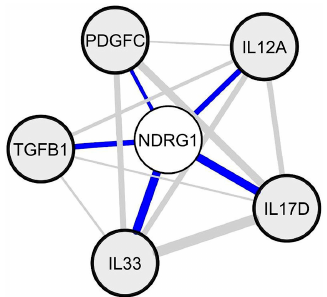
Figure 7. Identification of candidate soluble factors that putatively repress NDRG1 expression. Starting from a list of 193 candidate genes coding for cytokines, chemokines or growth factors, we used the GeneMANIA software to identify mRNA species whose levels inversely correlated with those of NDRG1 ( N -myc downstream regulated 1) in spinal cord periplaques. The top five genes whose expression levels inversely correlated with NDRG1 were: TGFB1 (transforming growth factor β 1) , IL33 (interleukin 33), IL17D (interleukin 17D), IL12A (interleukin 12A) and PDGFC (platelet derived growth factor C).